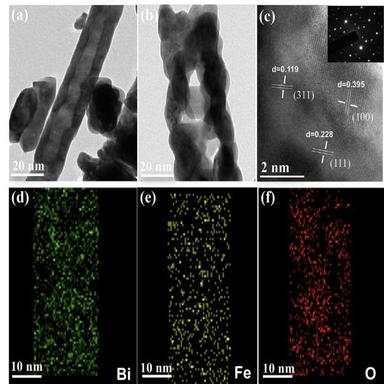
(a) TEM image of BFO nanotube with hollow structure and (b) pores on the sides of the tube wall. (c) High-resolution TEM images, (d–f) EDX elemental mapping of Bi, Fe, and O, of synthesized BFO.